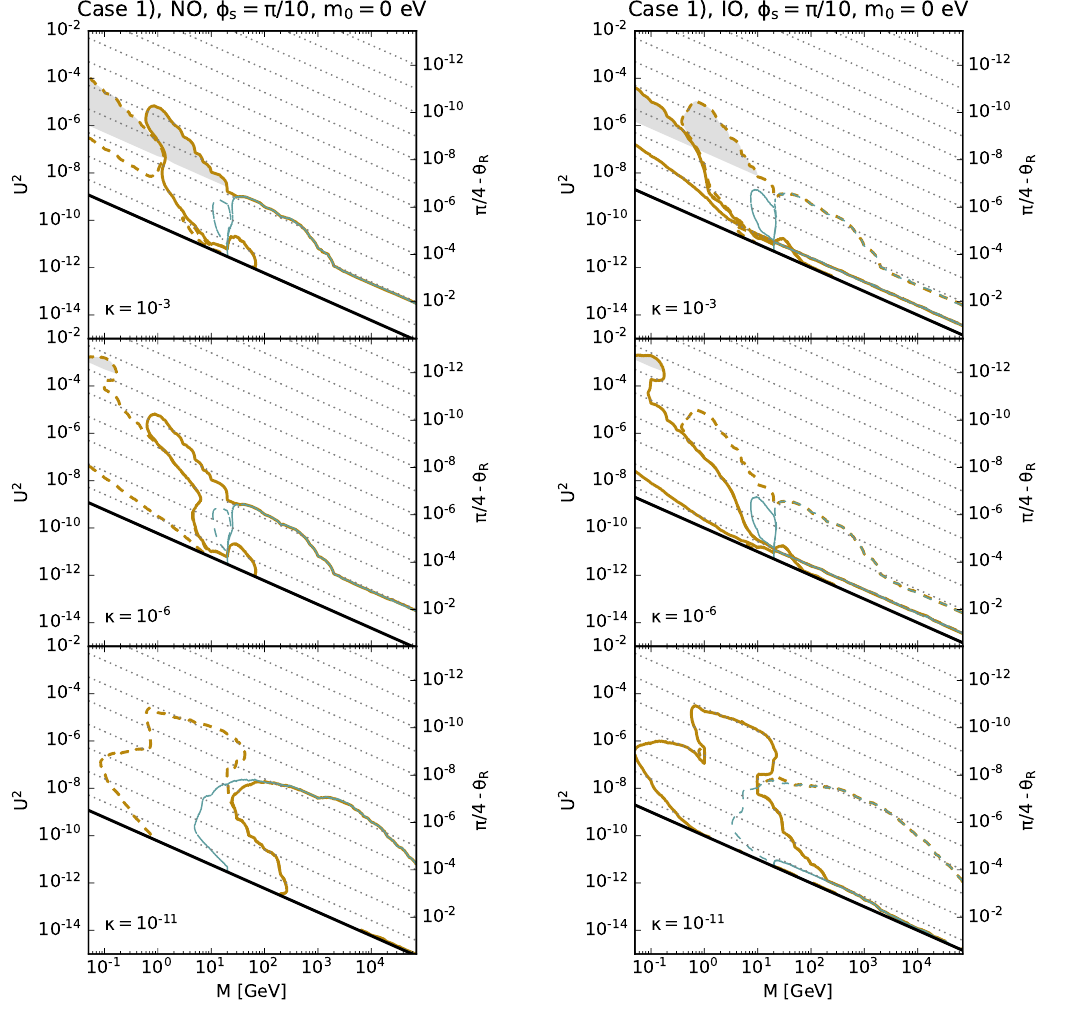
Figure 29 . Case 1) Range of total mixing angle U 2 consistent with the observed amount of BAU for heavy neutrino masses M between 50 MeV and 70 TeV, as presented in figure 9. The three rows correspond to different values of κ , κ ∈ { 10 − 3 , 10 − 6 , 10 − 11 } , respectively. The vanishing and thermal initial conditions are shown by the ochre and turquoise lines, respectively. The continuous (dashed) lines indicate positive (negative) values of the BAU. The grey shaded areas show the regions in which the condition in eq. (3.69) and alike is no longer satisfied. The value of the angle θ read